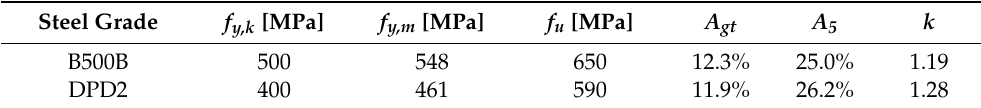
Figure 1. Stress-strain relationships of B500B and DPD2 steel grades.